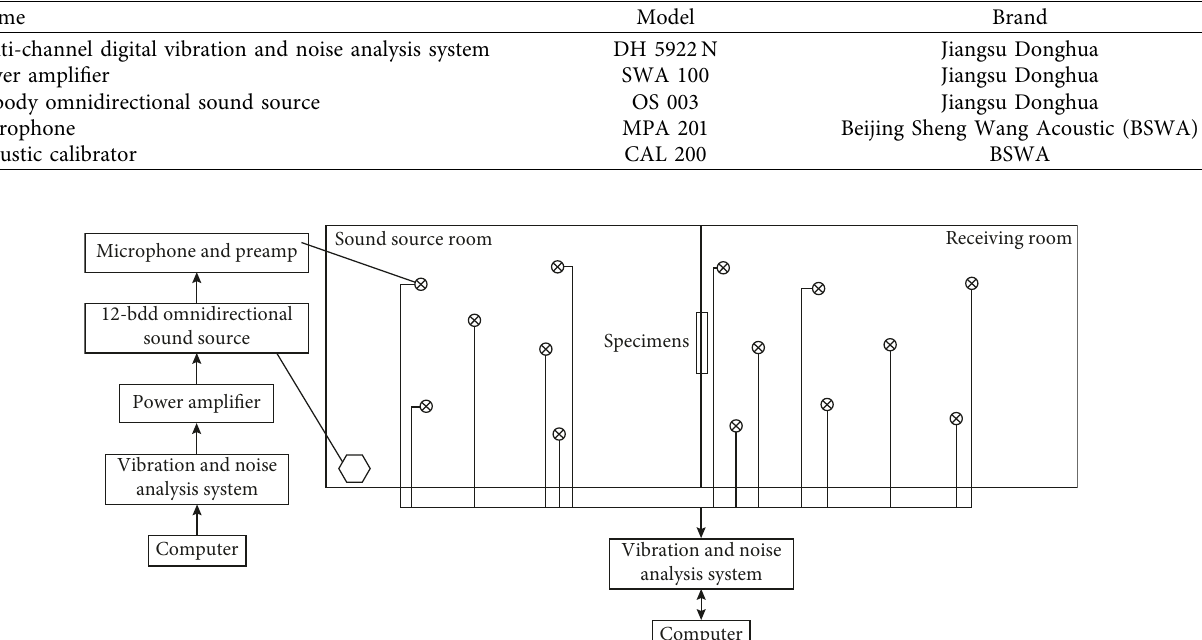
Figure 5: Vibration and noise analysis Table 3: The information of various instruments and equipment.